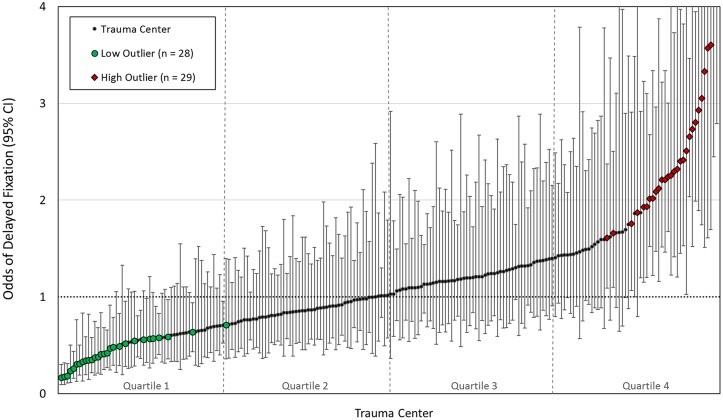
Caterpillar plot showing trauma center odds ratios (ORs) and 95% confidence intervals (Cis) for delayed fixation, risk-adjusted for patient baseline and injury characteristics.High outliers (greater than average odds of delayed fixation) and low outliers (lower than average odds of delayed fixation) are shown. In total, 57 (26%) centers showed significant differences in rates of delayed fixation unexplained by patient case mix. Data available in S3 Table.